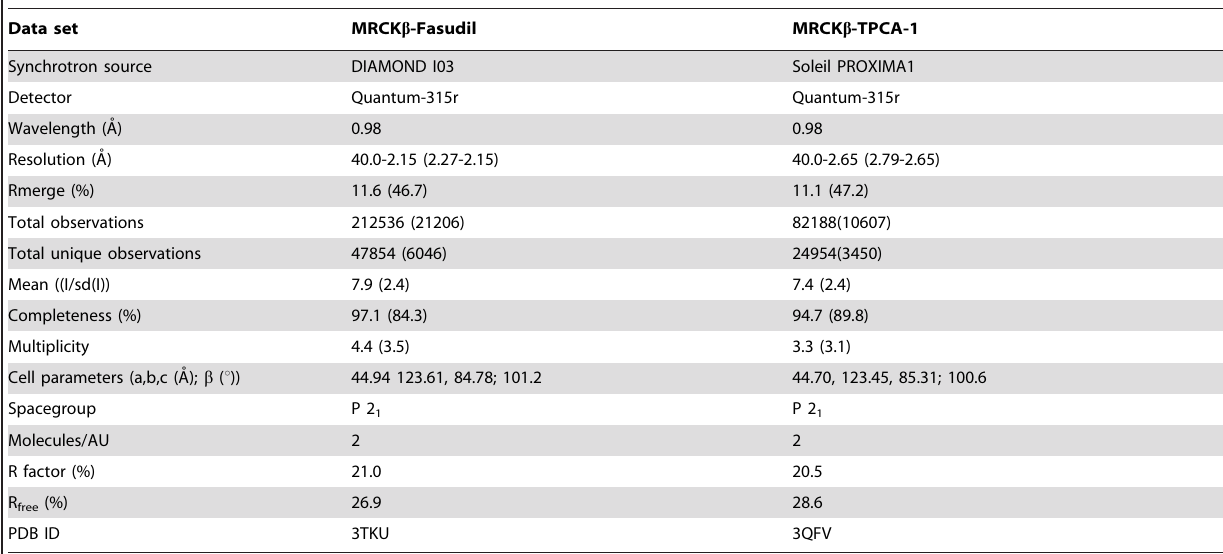
Table 3. Data collection and refinement